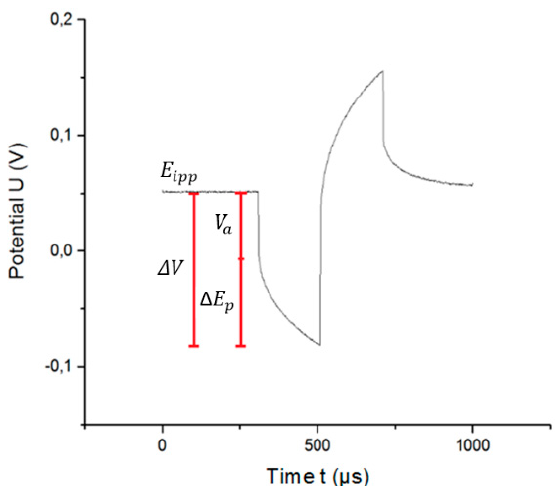
Figure 4. VT curve of electrode excited by a symmetric, biphasic current pulse. Pulse width is 200 µs and frequency is 50 Hz.